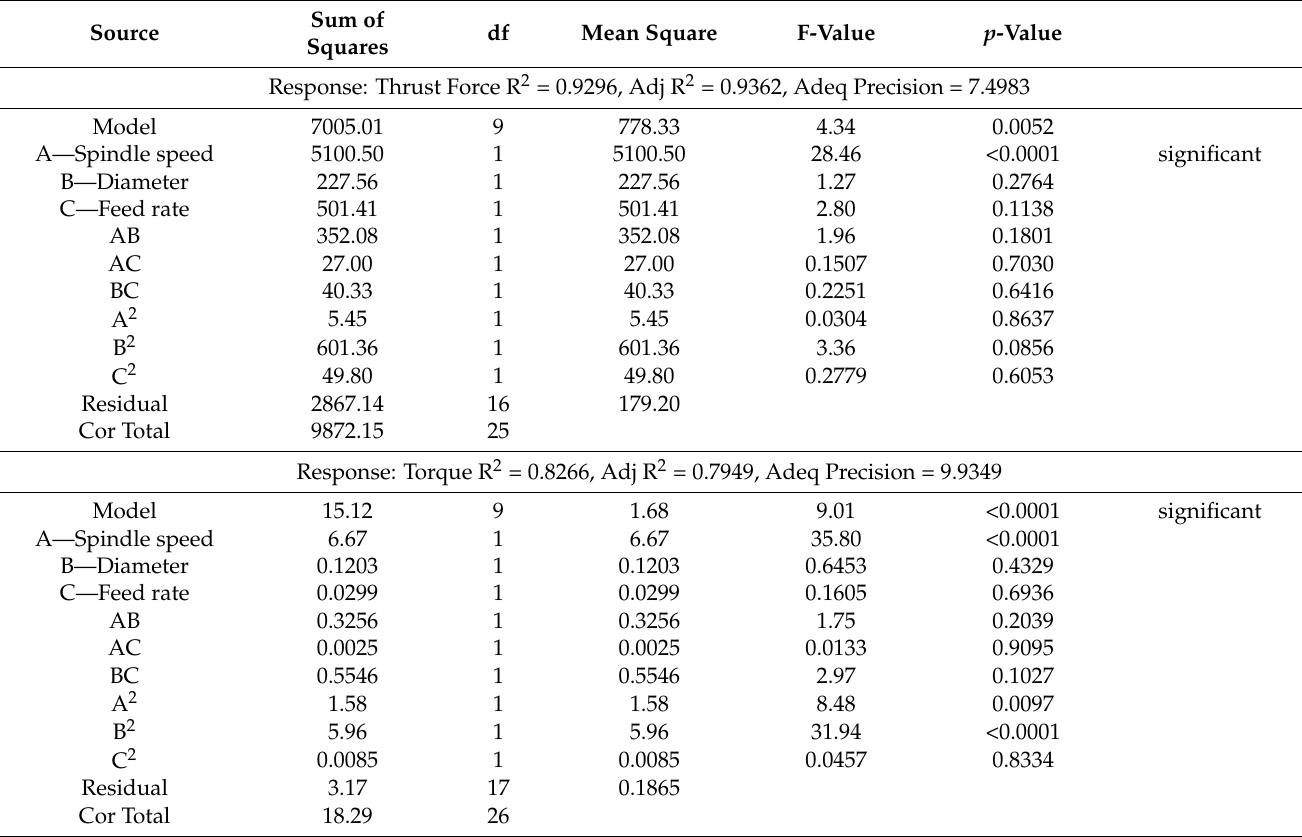
Table 6. ANOVA generated by the Design-Expert software for the response “Thrust Force” and